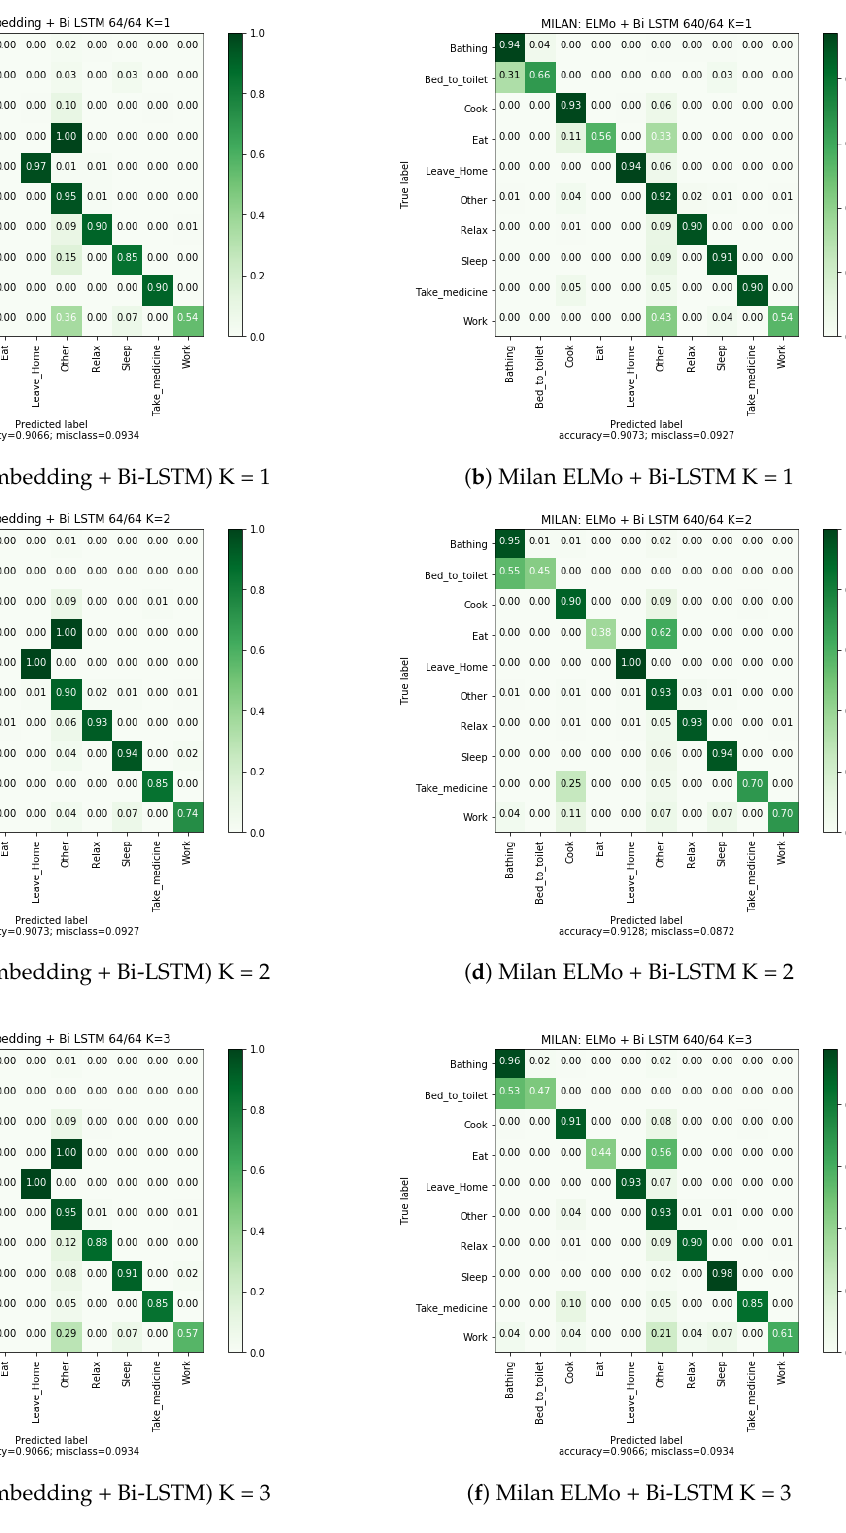
Figure A2. Milan confusion